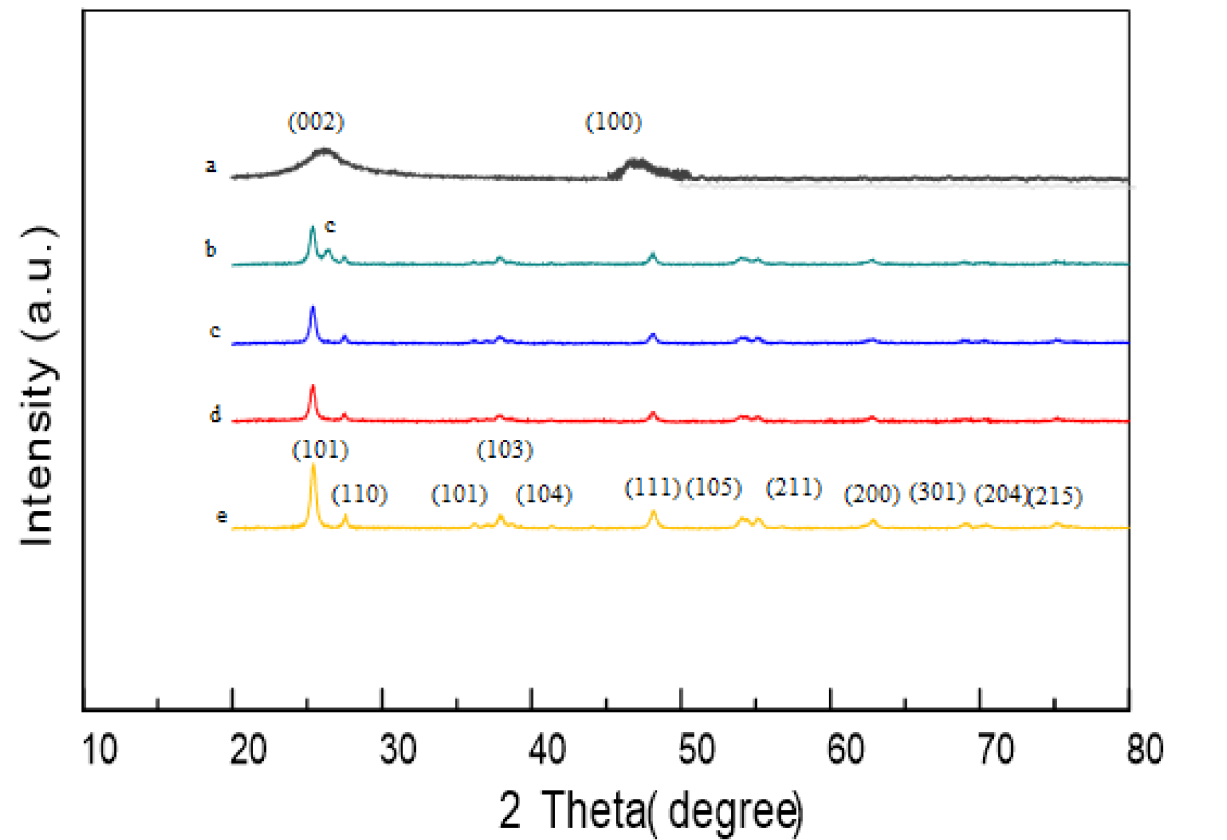
Fig 1. XRD patterns of acid treated MWCNTs (a), MWCNTs/TiO 2 (b) (1:1), (c) (1:2), (d)(1:3), and (e) TiO 2 -p25.